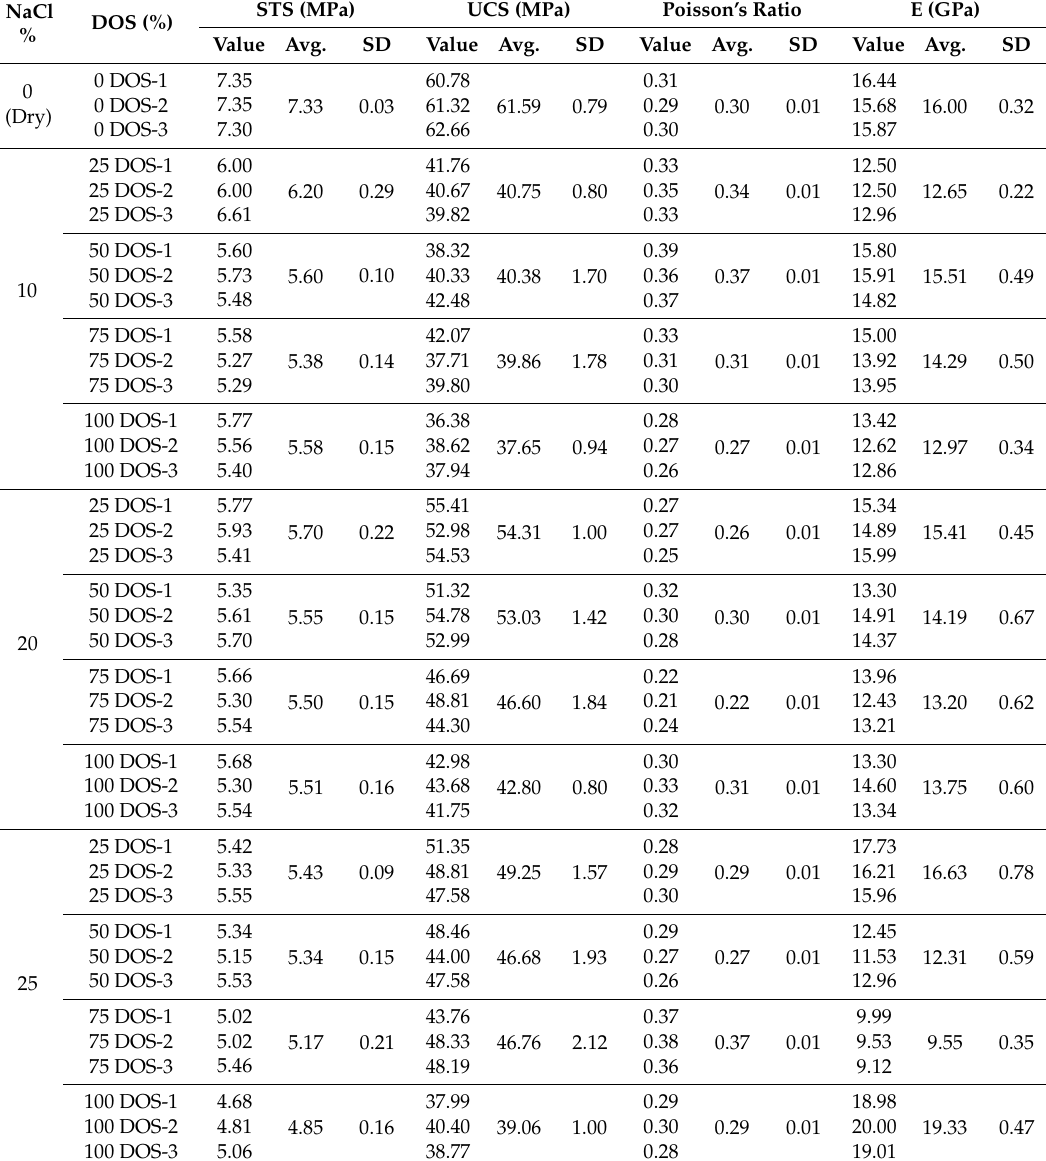
Table 1. Mechanical properties of dry and brine-saturated siltstone.